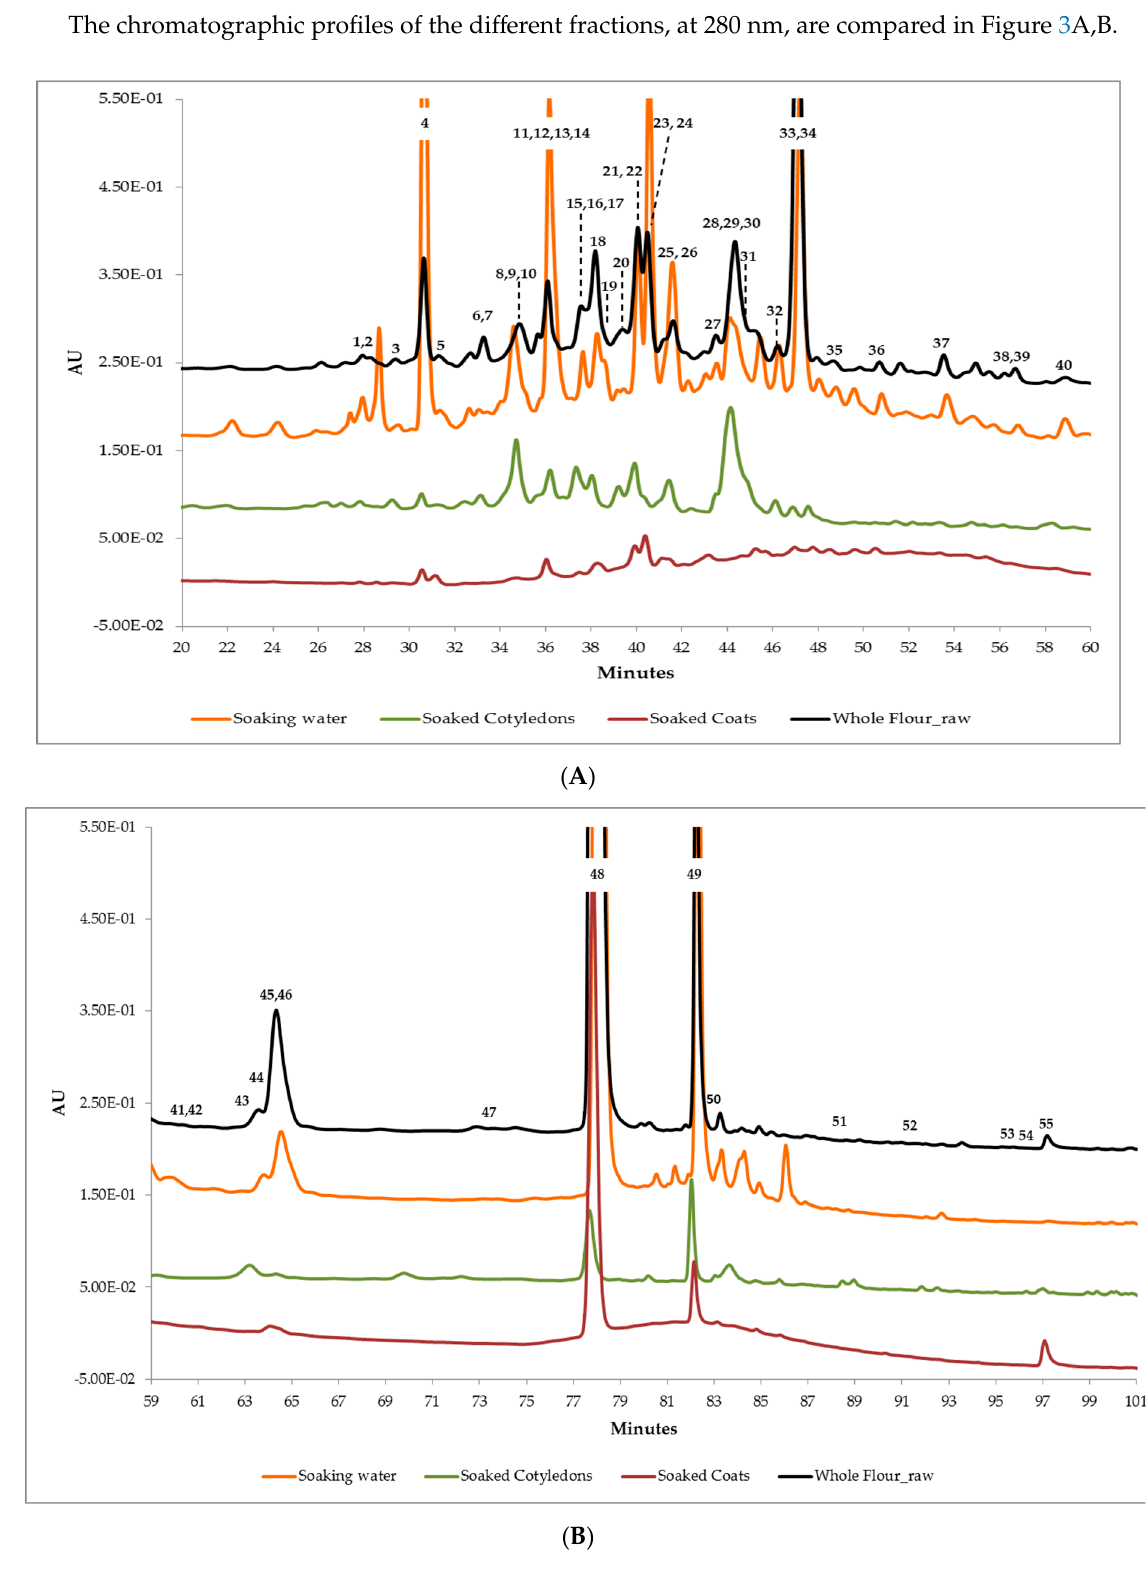
Figure 3. ( A ) Zoom of the chromatographic profiles of sample’s 22 fractions (20–60 min) at 280 nm. The numbers highlight the identified compounds in Table 4. ( B ) Zoom of the chromatographic profiles of sample’s 22 fractions (59–101 min) at 280 nm. The numbers highlight the identified compounds in Table 4.